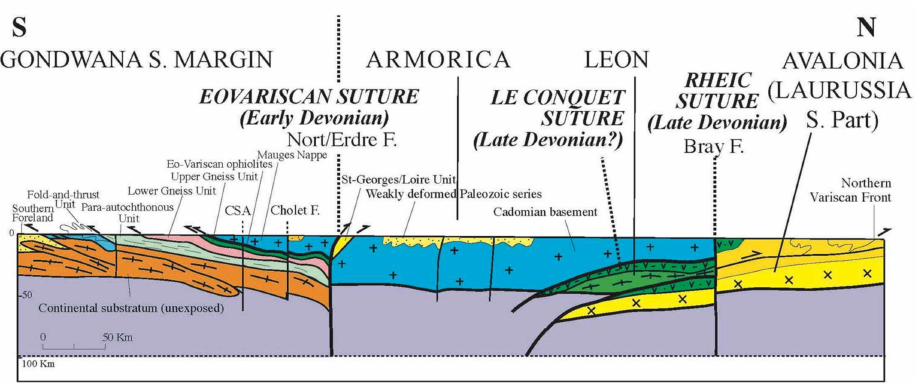
Figure 3. Simplified crustal-scale cross-section of the Variscan orogen in the French segment (located in Figure 2, modified from [16]). The southern part of the belt is related to the Early to Middle Devonian eo-Variscan collision of the North Gondwana margin and Armorica. Note that in Figure 2 the detail of the nappe stack is not represented. To the North, the Rheic suture separates the Avalonia (i.e., the southern margin of Laurussia) and the L é on microcontinent belonging to the Saxo-Thuringian domain. The Le Conquet (or Tepla) suture separates the L é on microcontinent and Armorica. For clarity, the late-orogenic plutons and migmatitic massifs have been